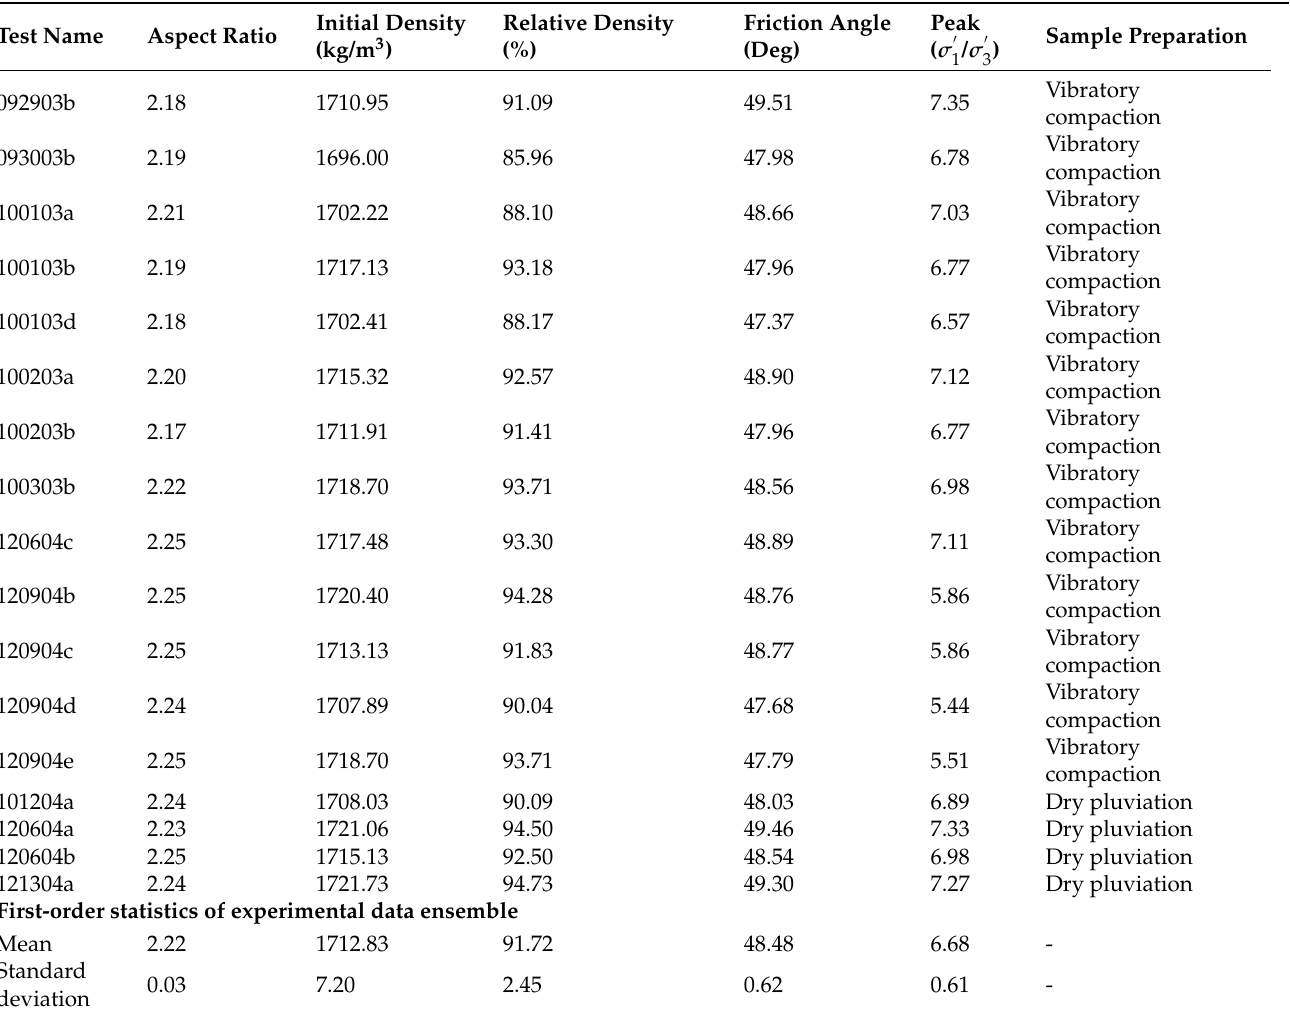
Table 1. Summary of sample